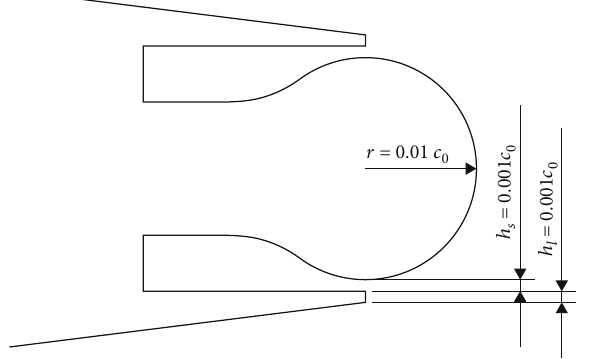
Figure 1: Coanda trailing edge of the modi fi ed